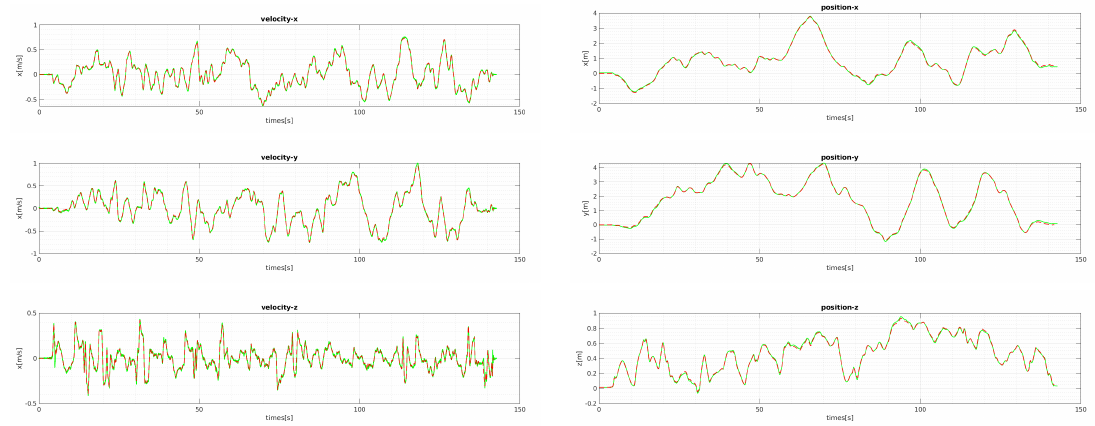
Figure 13. The comparison of the ground-truth velocities and positions with ours for V1 01. The ground- truth values are plotted in green lines, and the estimated values are the red dashed lines. The positions and velocities computed by the estimated scale from the bootstrapping and updated by the local scale parameter align well with the